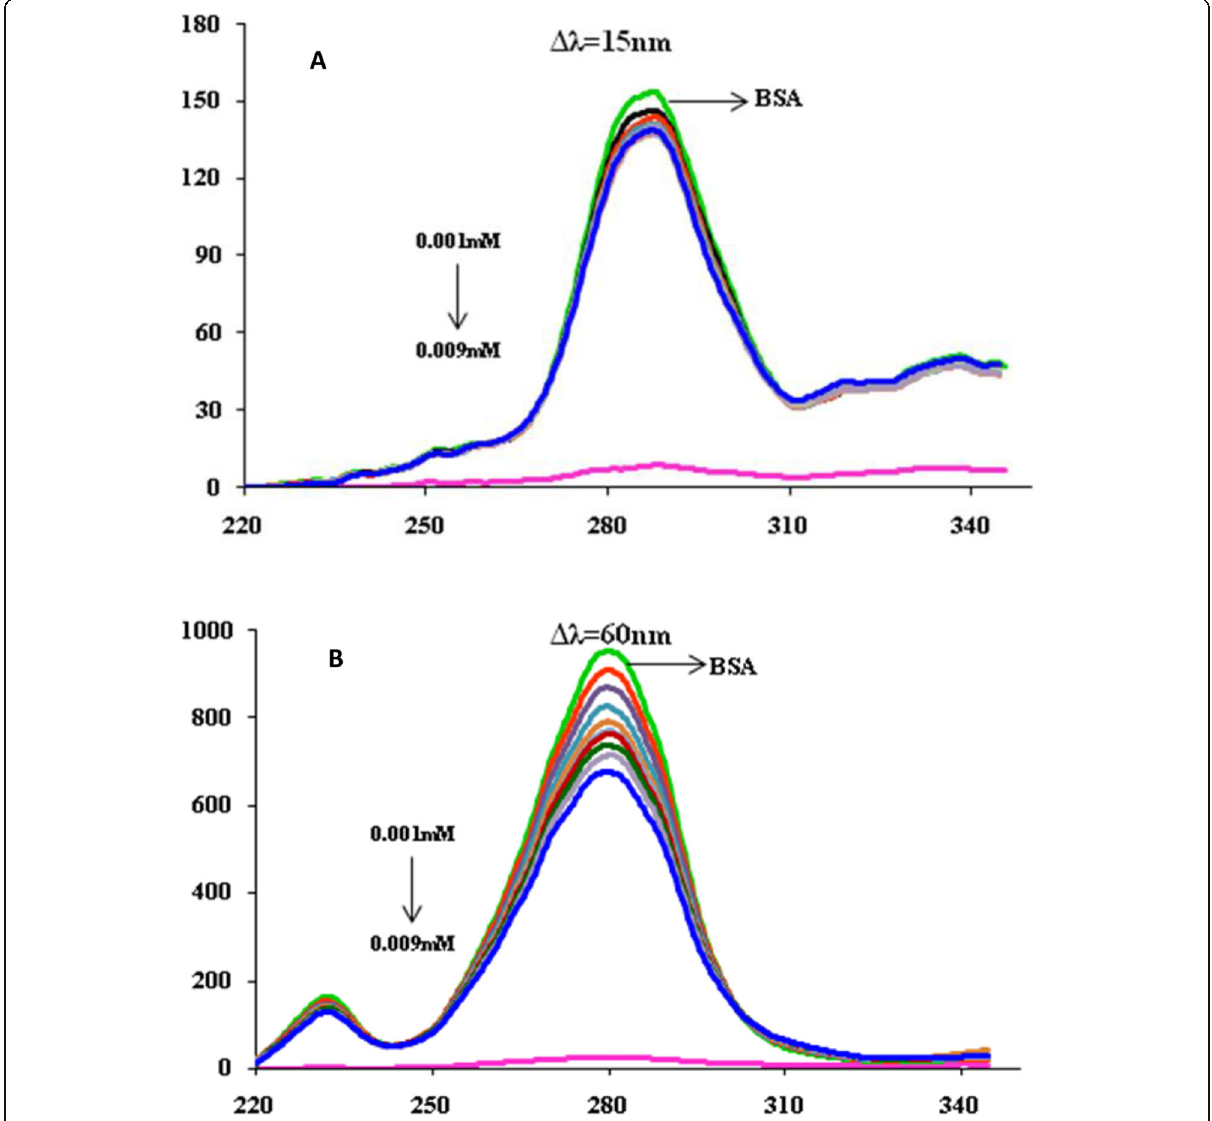
Fig. 7 The synchronous fluorescence emission spectra of BSA – 5-HMP complex at different Δλ values. a Δλ 15 for tyrosine residue and b Δλ 60 for tryptophan